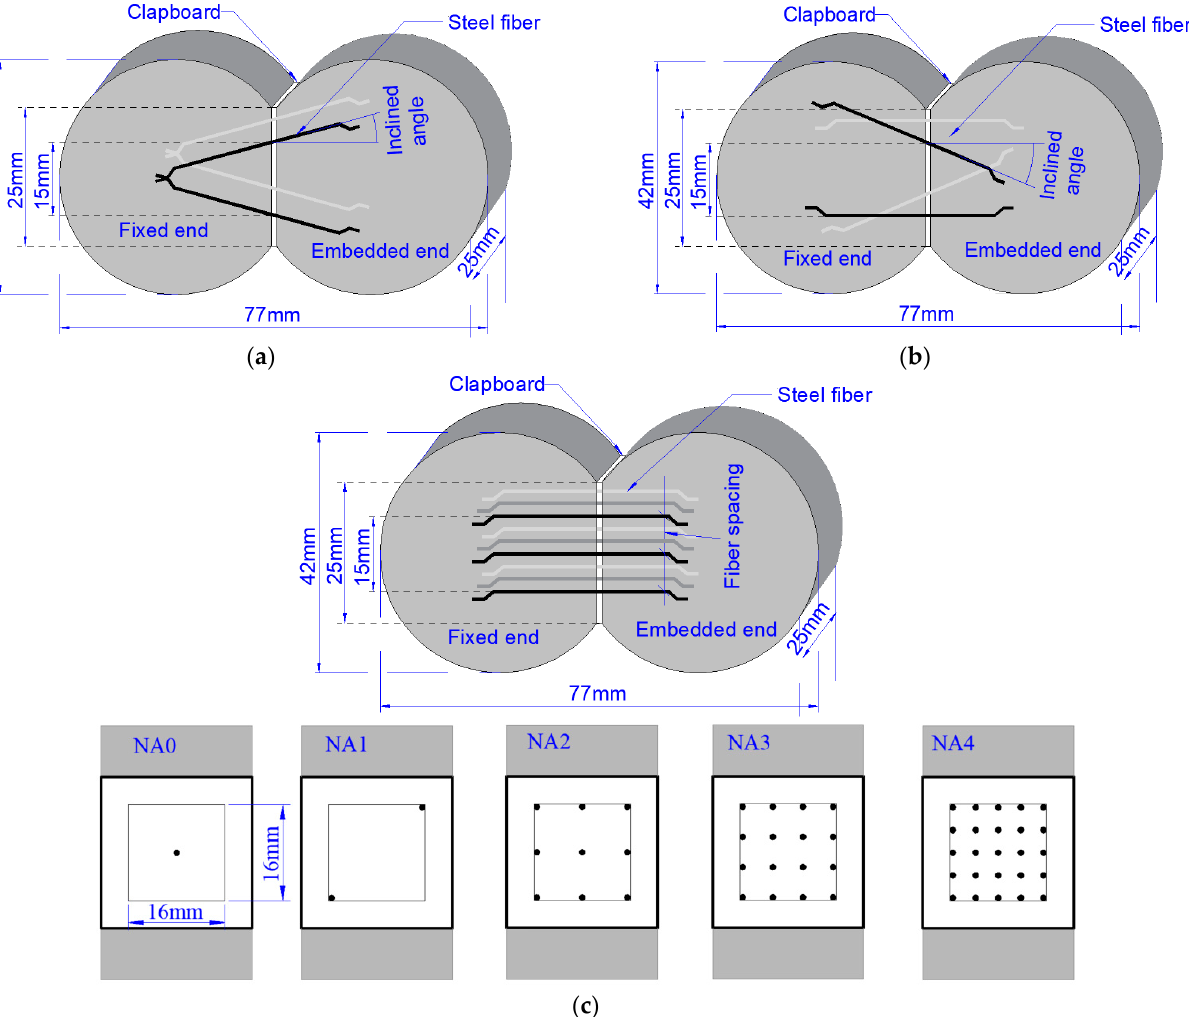
Figure 1. The geometric details of specimen for the pullout test. ( a ) Series IA ( b ) Series HIA ( c ) Series NA.